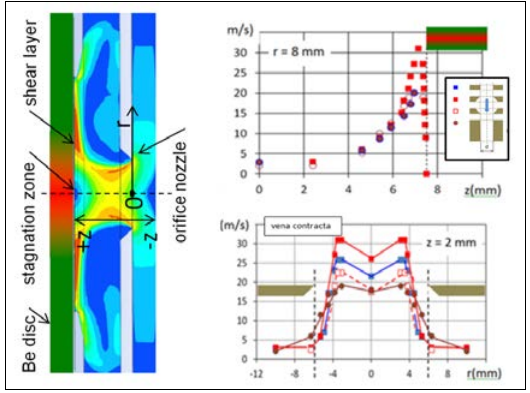
Fig. 3. Resulting velocity distribution of cooling fluid in the shear layer and vena-contracta region for various form of the orifice nozzle. The open sharp-edge orifice was selected as the optimal solution.